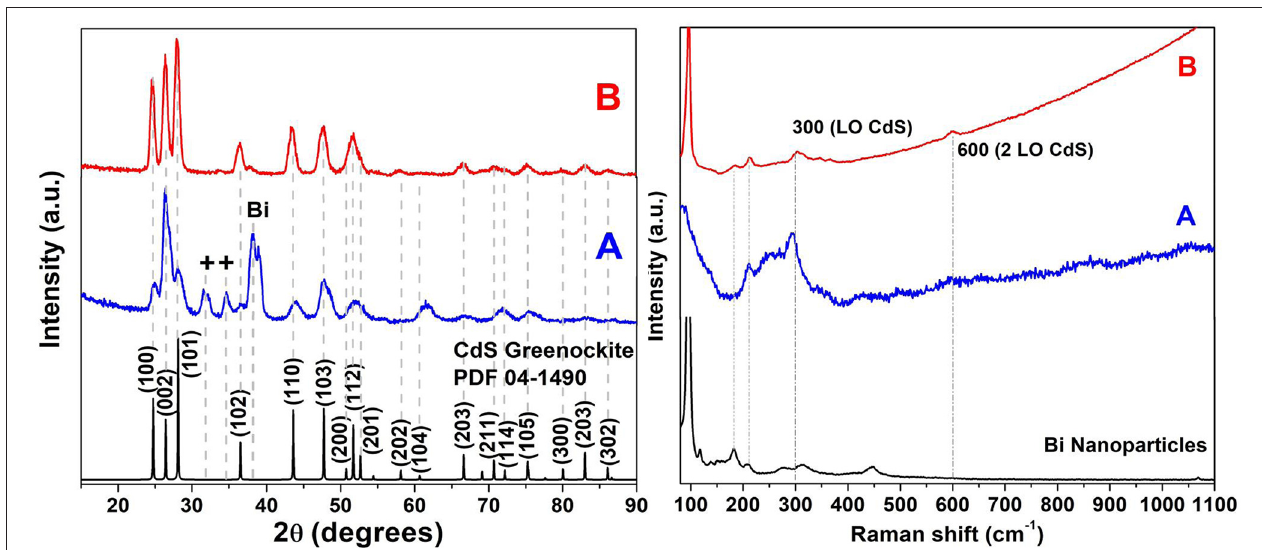
FIGURE 5 | (A) XRD diffractogram for samples A and B showing the characteristic peaks of the CdS with Greenockite phase (the peaks marked with + symbols come from the SnO 2 substrate). (B) Raman spectra of nanowires and nanoparticles. The vibrational modes 1LO and 2LO corresponding to CdS with Greenockite phase are